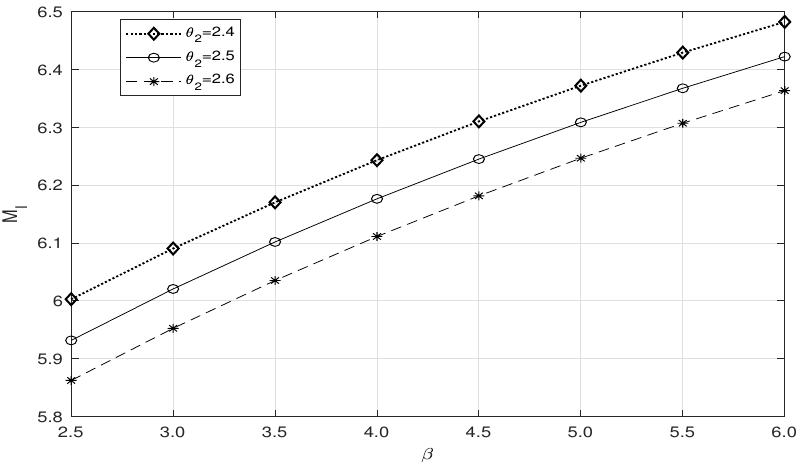
Figure 11. Mean number of items in the inventory on θ 2 vs. β .